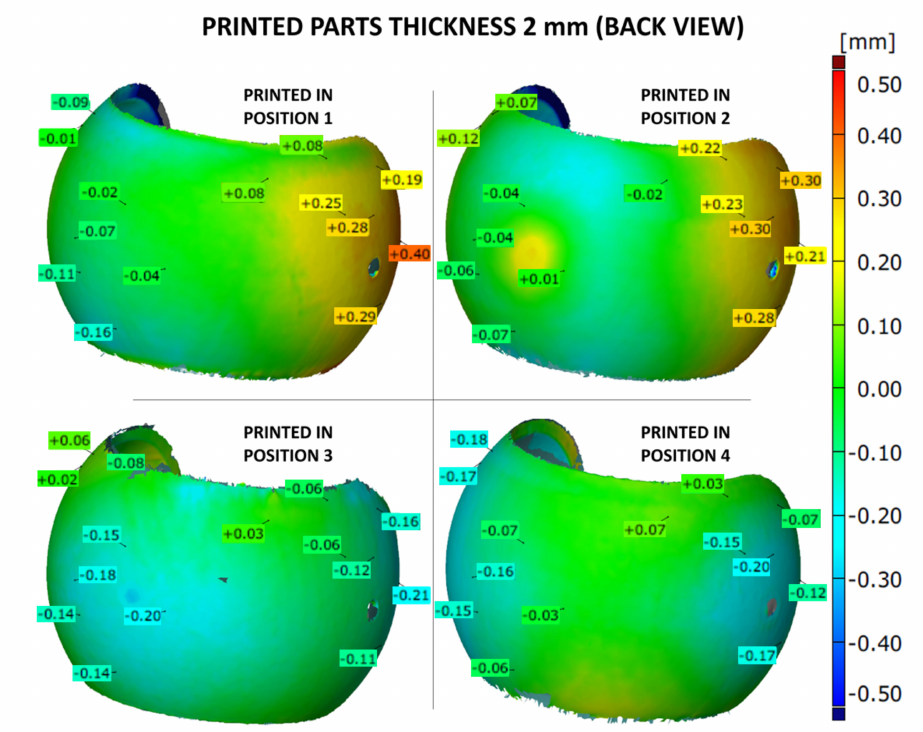
Figure 10. Geometry deviations of the 3D printed part with a thickness of 2 mm (back view).